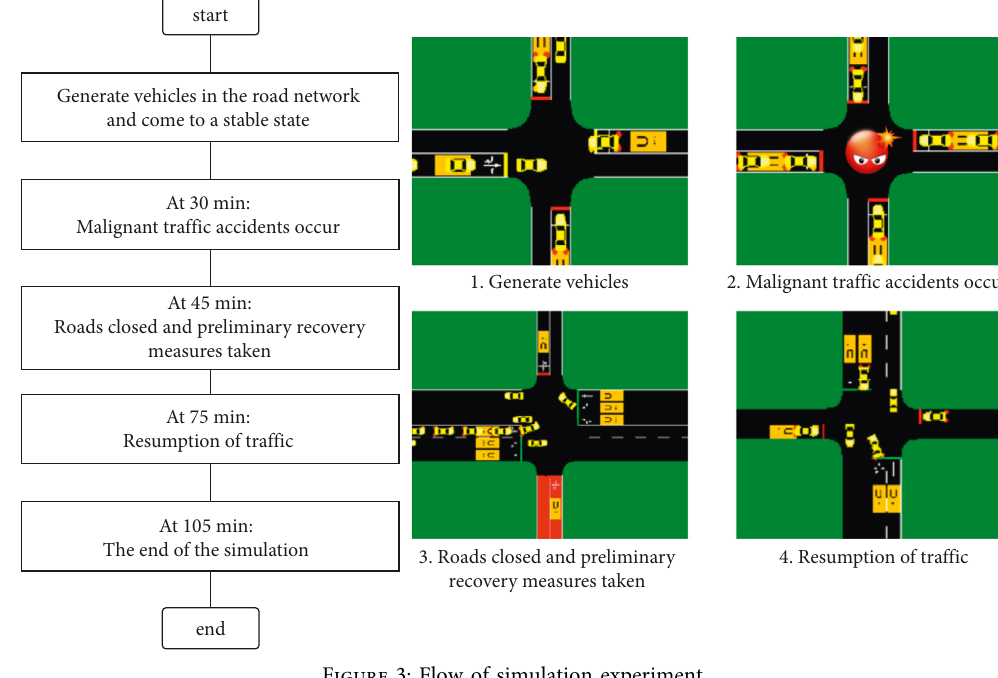
Figure 3: Flow of simulation experiment.